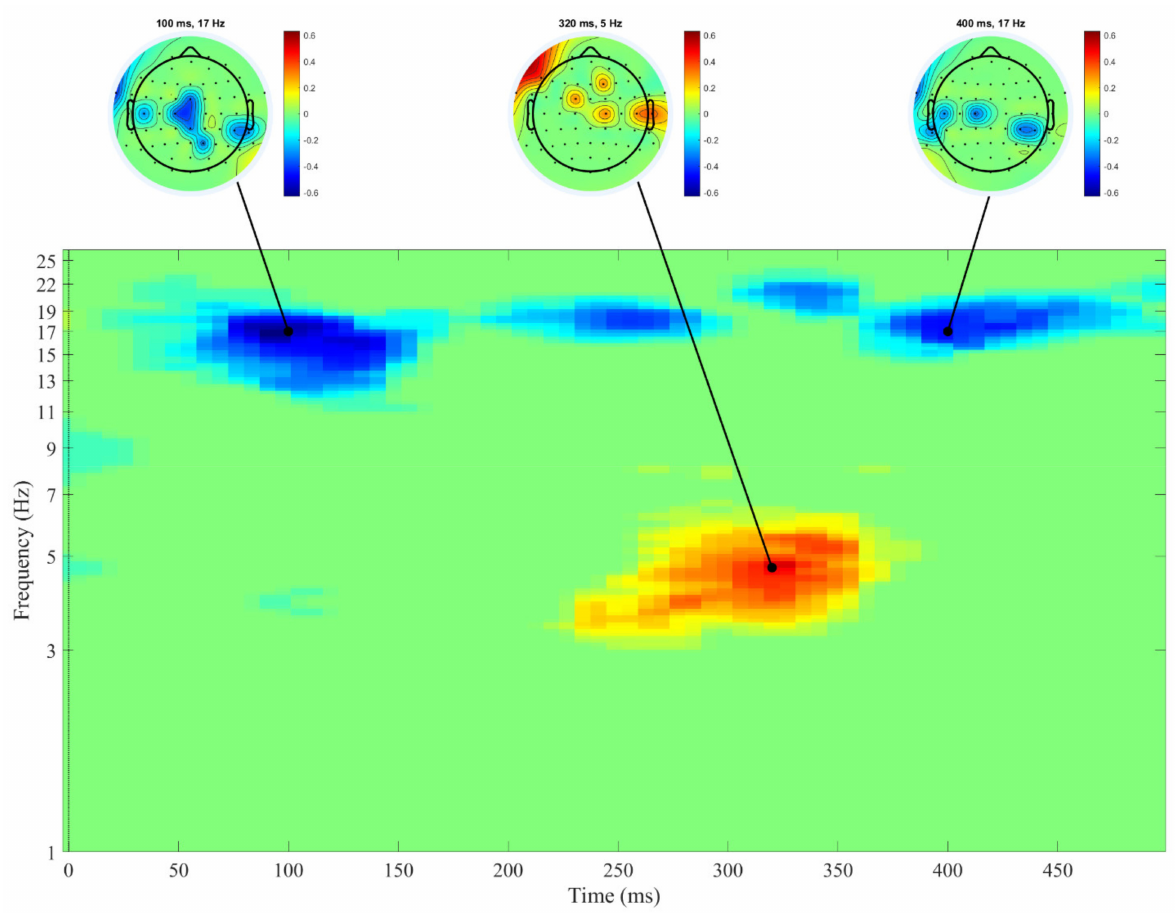
Figure 3. Correlations between inattention scores and ERSPs after the presentation of the Go stimulus. Positive correlation coefficients are shown in warm colors, negative correlation coefficients are shown in cool colors. Darker colors correspond to stronger correlations (see vertical bars for exact values). Time-frequency areas with non-significant correlation coefficients are shown in green. The moment when the stimulus was presented is represented by 0. Heads at the top of the figure display the distribution of significant correlation coefficients in the maps of electrodes. n =